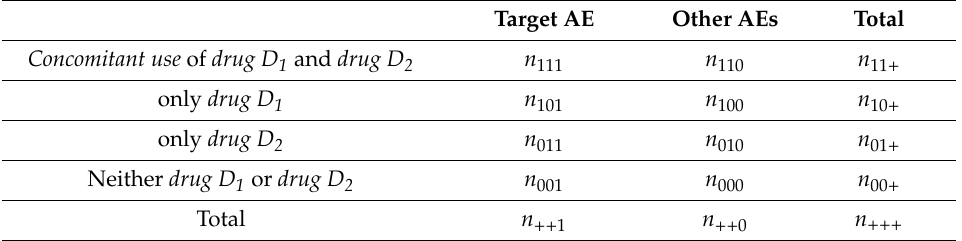
Table 1. The 4 × 2 contingency table for signal detection: AE: adverse event; n: the number of reports (e.g., n +++ : the number of all reports, n 111 : the number of drug D 1 - and drug D 2 -induced target AE